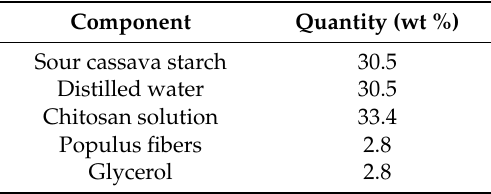
Table 1. Formulation of the adhesive